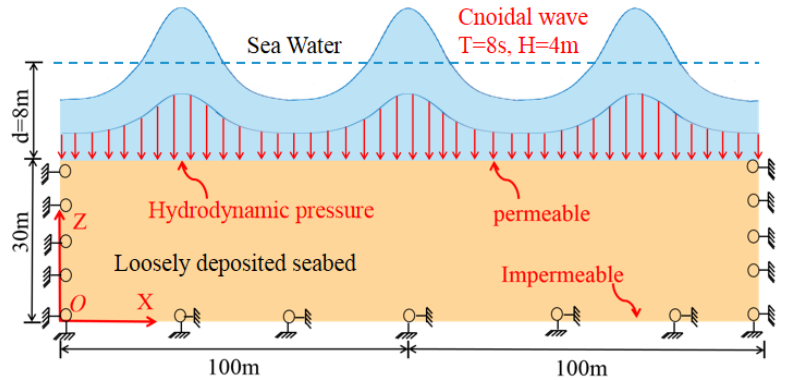
Figure 1. Diagram of the computational domain for the seabed floor.